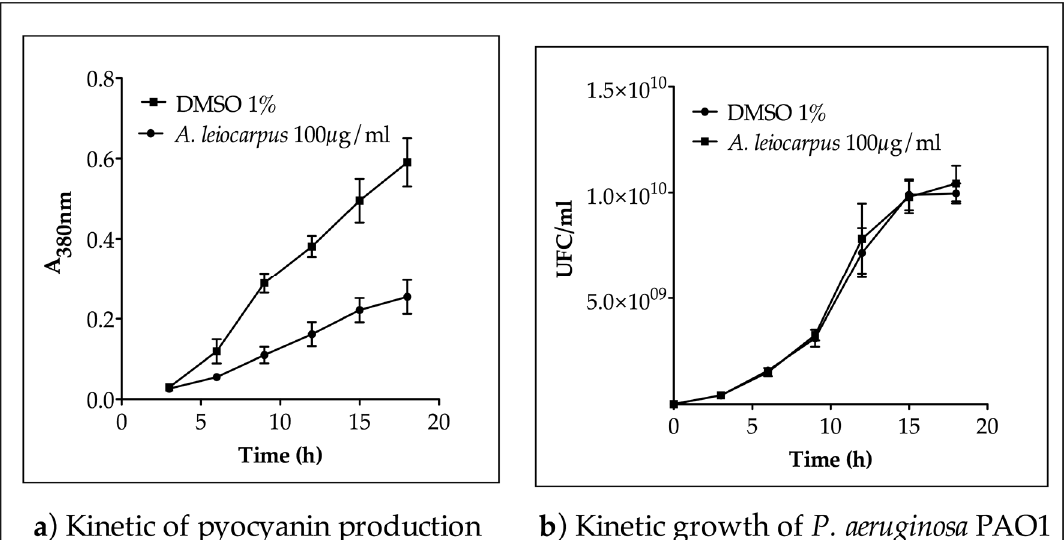
Figure 1. Methanol extract from A. leiocarpus reduce pyocyanin production in P. aeruginosa PAO1. ( a ) A. leiocarpus extract (100 µ g/mL) significantly reduced ( p > 0.05) pyocyanin production within 18 h compared to DMSO used as control; ( b ) A. leiocarpus extract (100 µ g/mL) did not exhibit a significant effect on P. aeruginosa PAO1 kinetic growth within 18 h. Dimethyl sulfoxide (DMSO) was used as negative control. P. aeruginosa PAO1 was grown (37 °C, 175 rpm agitation) in the LB broth. Mean values ± SD of triplicate independent experiments are shown.